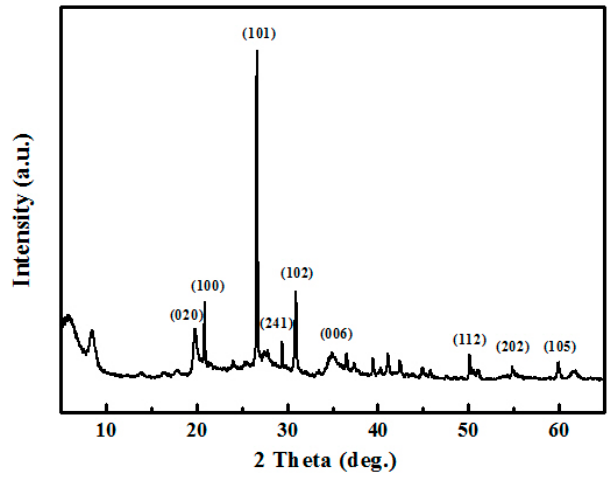
Figure 4. XRD pattern of the pristine palygorskite powders.